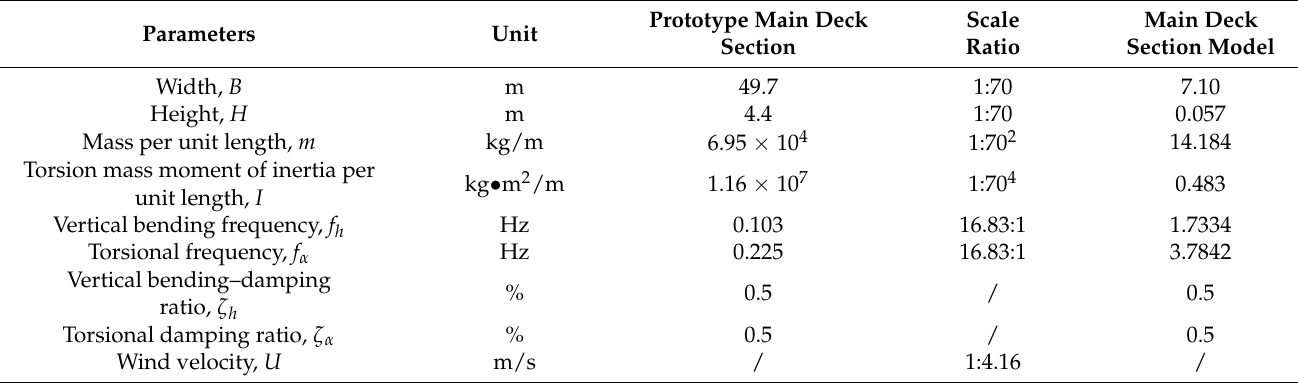
Table 5. Main parameters of the main deck section of